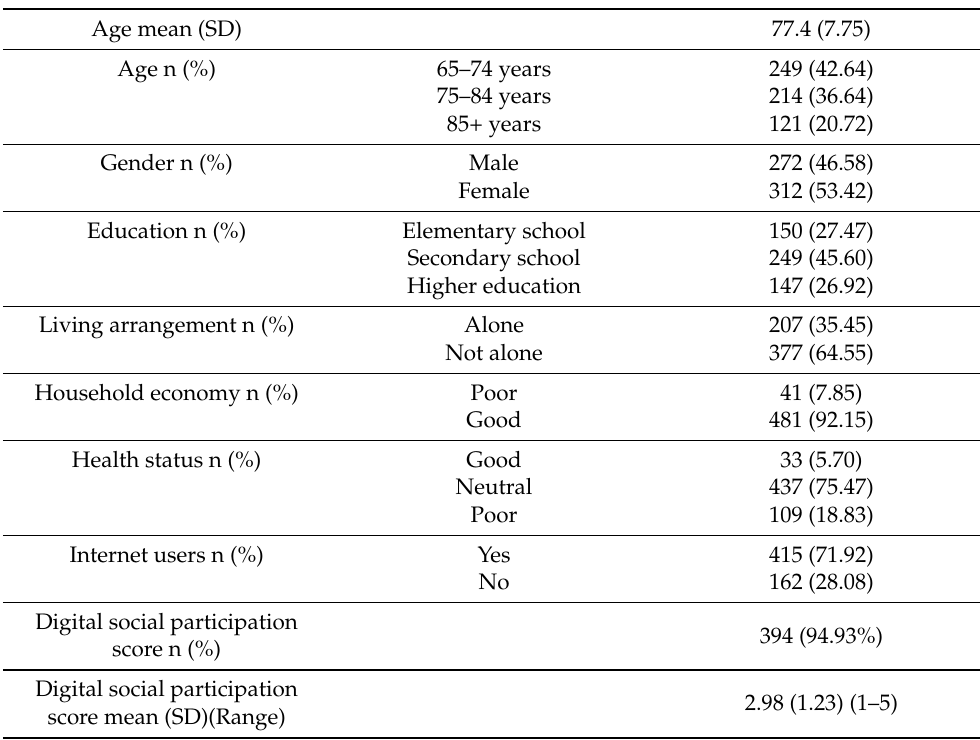
Table 1. Characteristics of the sample (N = 548) in terms of socio-demographic variables and digital social participation.